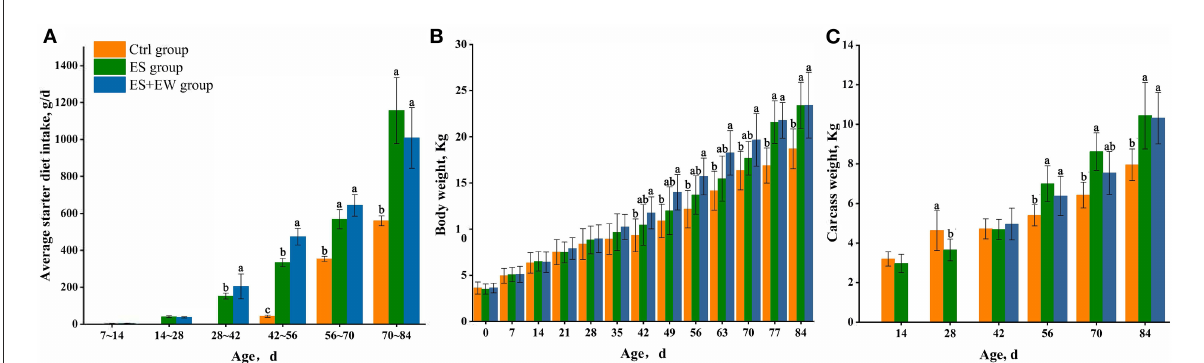
FIGURE2 Average starter diet intake (A) , body weight (B) , and carcass weight (C) of lambs in different early feeding strategies. Columns with different letters at a single time point indicate means that differed based on the means separation ( P < 0.05). Error bars indicate SEM for the treatment × age